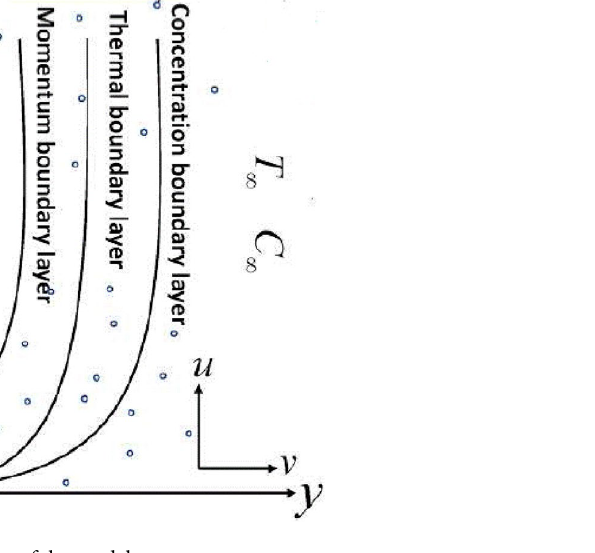
Figure 1. Schematic diagram of the